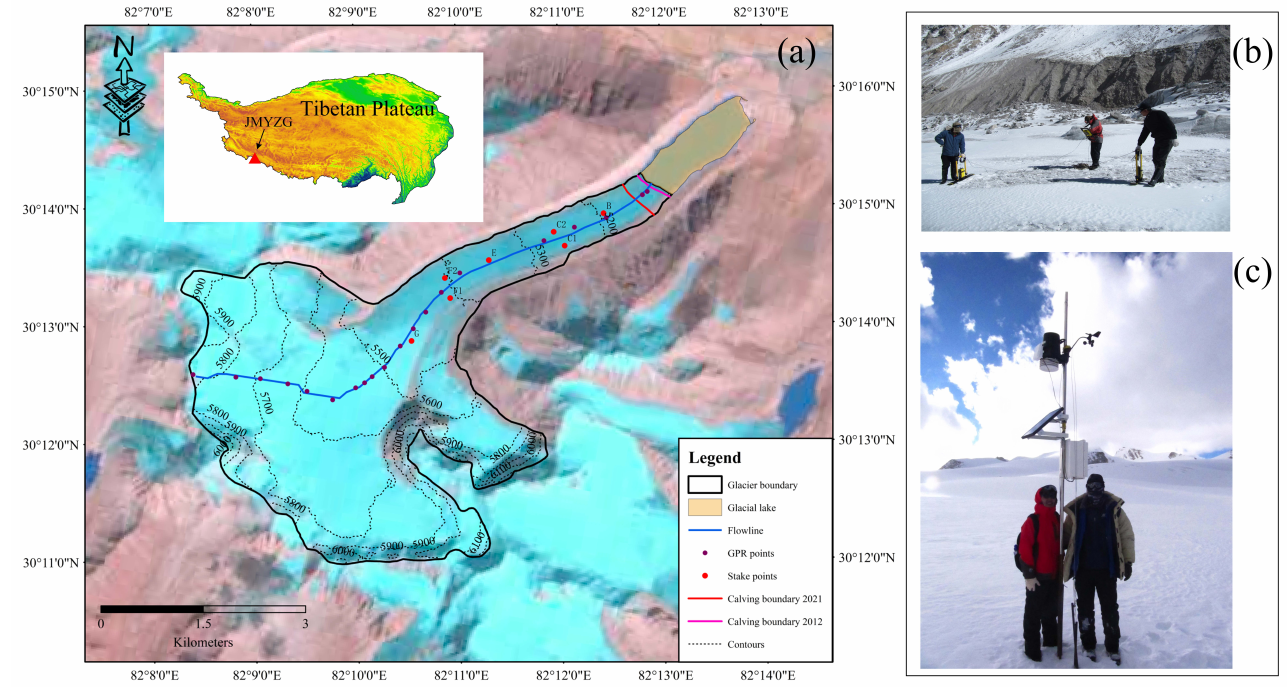
Figure 1. ( a ) A map of JMYZG. The blue solid line is the flowline in the ice flow model; the red points (B ∼ G) are the stakes; the brown points along the flowline are the ground penetrating radar points; the red and pink solid lines at the terminus of the glacier are the calving fronts in 2012 and 2021 (the rest of the years are not shown), respectively. The background is the Tibetan Plateau from the Landsat-5 TM image acquired in 2011 and the contours obtained from SRTM DEM in 1 arc (approximately 30 m). ( b ) GPR measurement at JMYZG. ( c ) A weather station at an altitude of approximately 5500